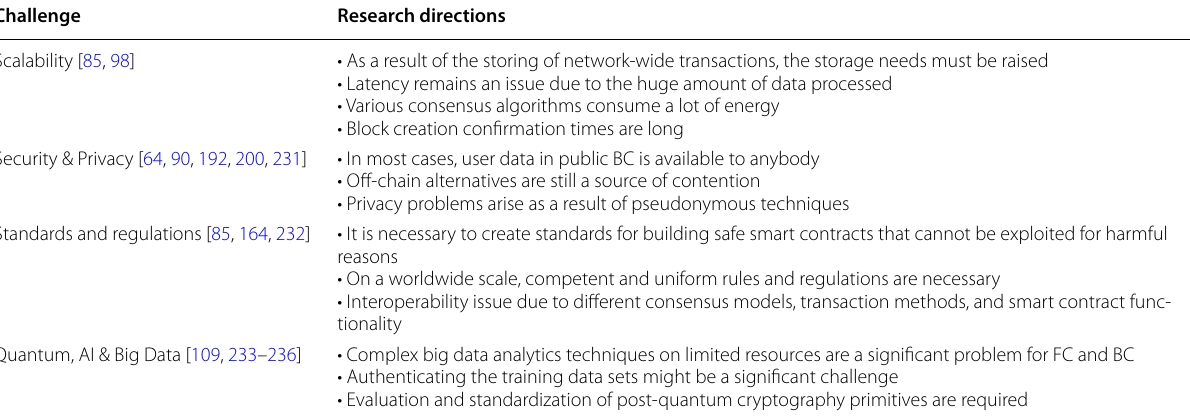
Table 3 BC with FC integration limitations and future directions